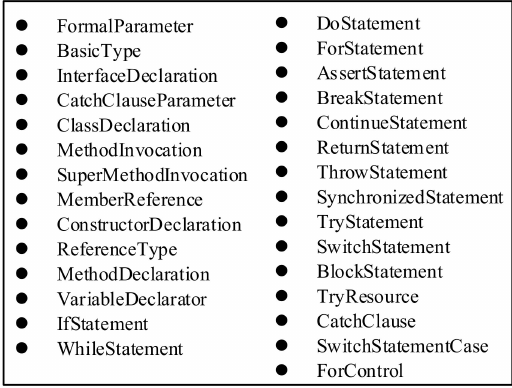
Figure 6. Selected abstract syntax tree (AST) node